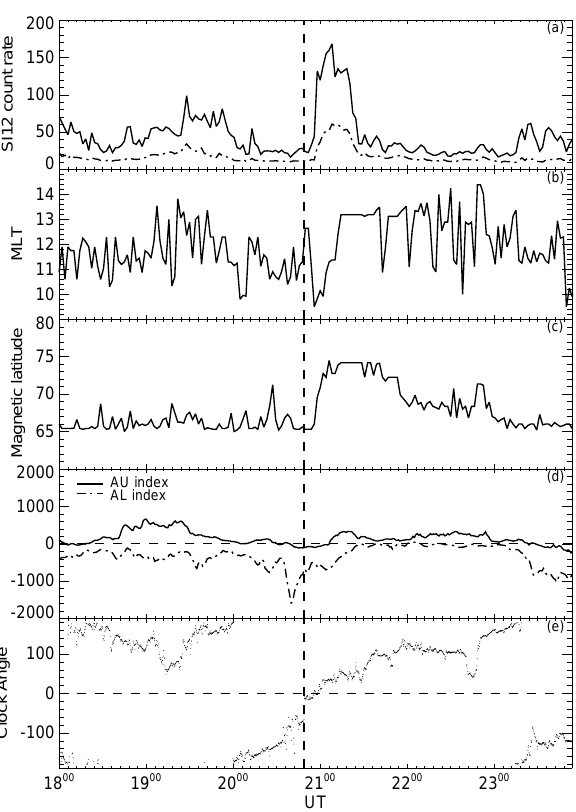
Fig. 9. (a) The maximum and mean brightness of a dayside portion of the auroral oval, between 9.5 and 14.5 MLT and 65–75 ◦ latitude. (b) The magnetic local time of the brightest pixel within this area (c) The magnetic latitude of the brightest pixel within this area (d) The AL and AU indices during the interval of interest (e) the clock angle measured by ACE, lagged to the magnetiopause. The vertical dashed line marks the onset of dual lobe reconnection.